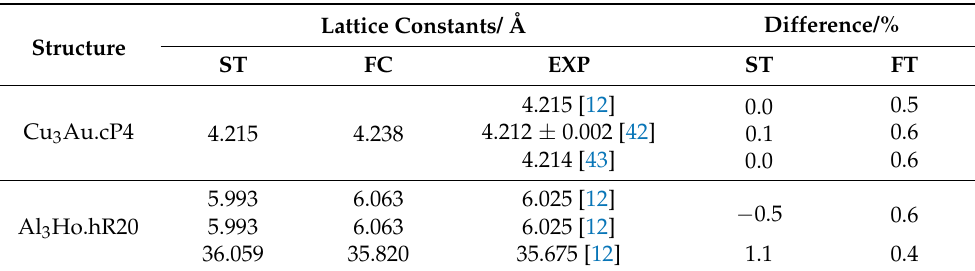
Table 1. The calculated and experimental lattice constants of Al 3 Er in Cu 3 Au.cP4 and Al 3 Ho.hR20 structures with different potentials.